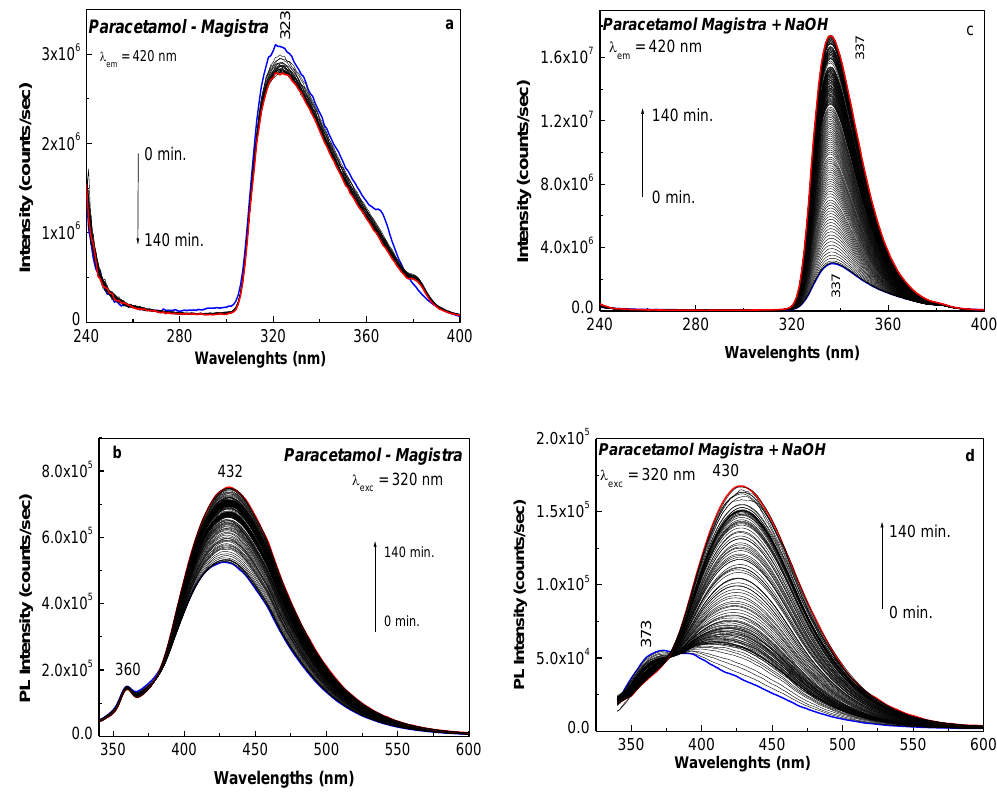
Figure 3. The PLE and PL spectra of the aqueous solution of Paracetamol before ( a , b ) and after the interaction with the aqueous solution of NaOH 3 × 10 − 1 M ( c , d ). Blue and red curves correspond to the first and last spectrum, respectively, of the samples exposed to UV light for 0 and 140 min. Black curves correspond to the intermediate spectra of above samples, each PLE and PL spectrum being collected at 84 and 140 s, respectively.